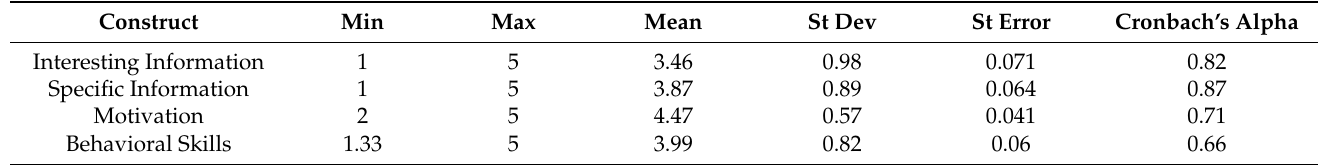
Table 4. Descriptive Statistics of IMB Construct Responses for All Messages †